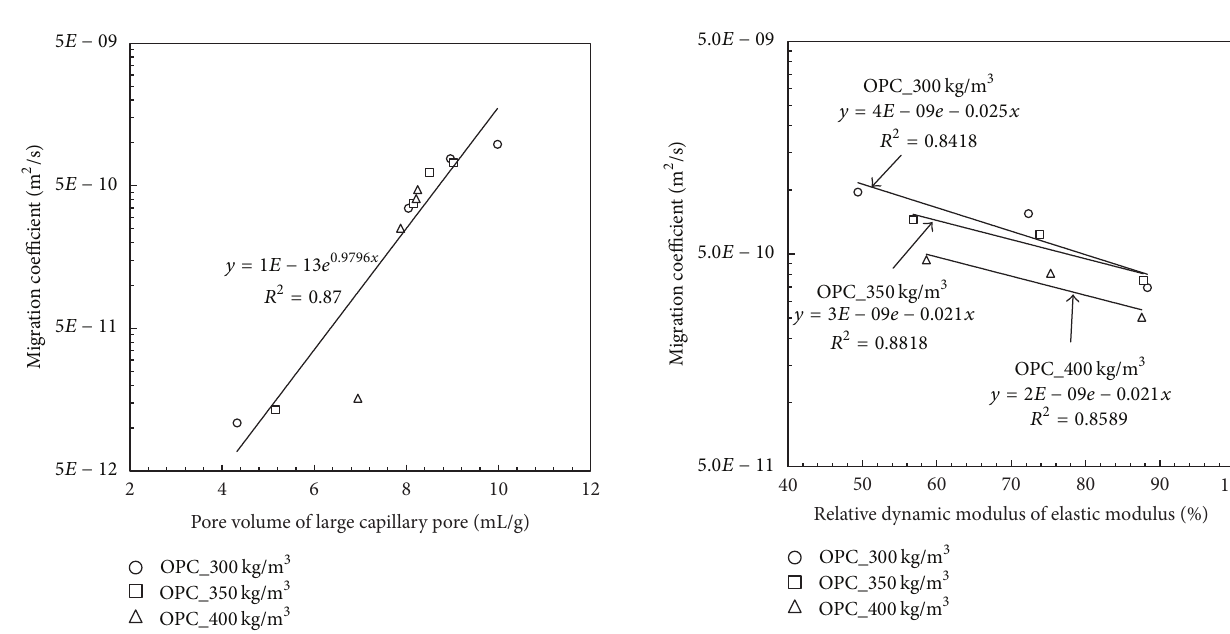
Figure 5: The relation between chloride migration coefficient and pore volume of large capillary pores for three different cement content in the concrete mix at freeze-thaw environment.